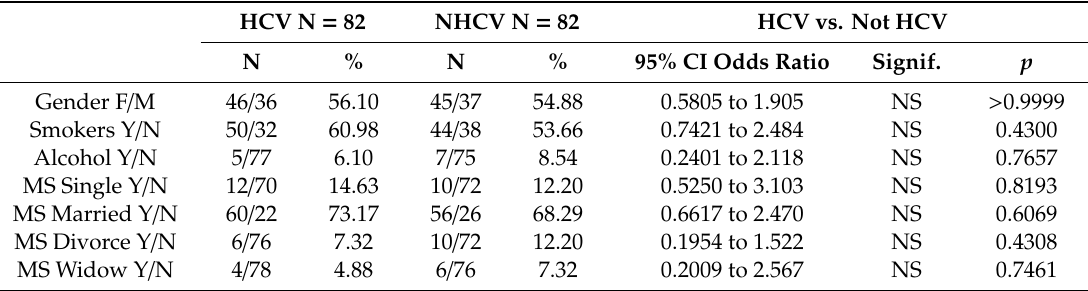
Table 1. Gender and lifestyle